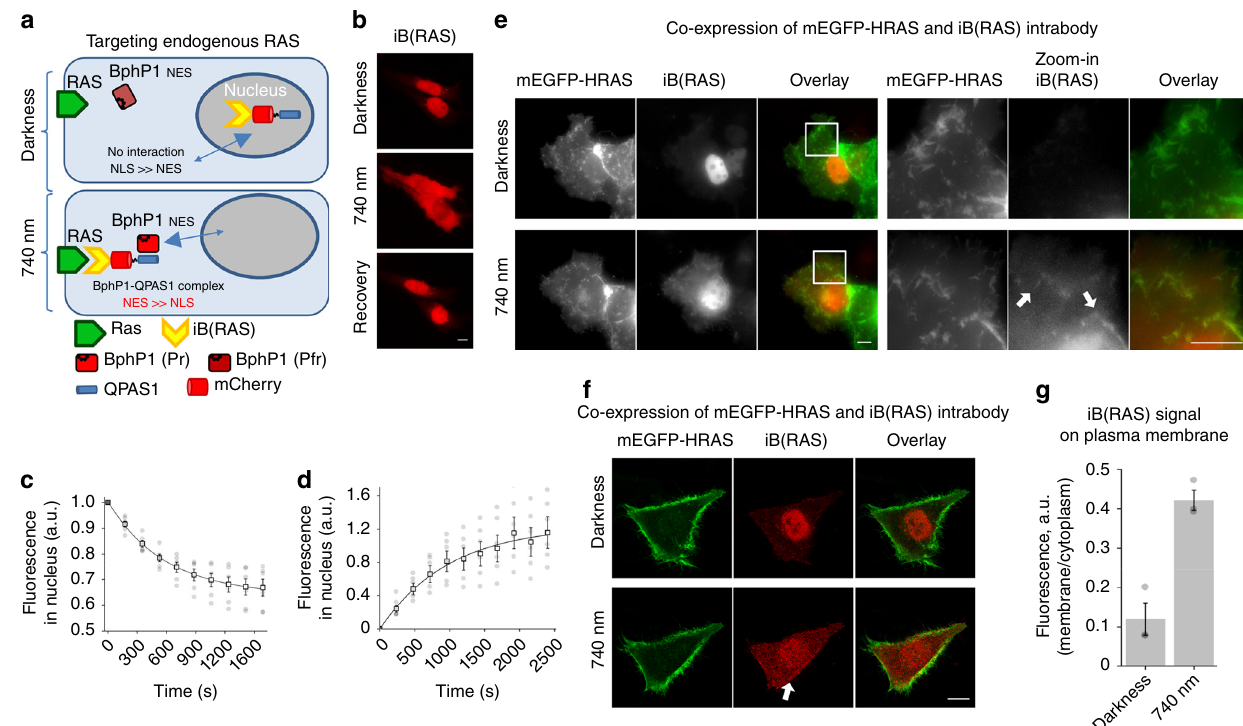
Fig. 6 Engineering of light-controlled intrabody for endogenous RAS. a Schematic representation of a regulation of the intrabody against RAS, designated “ iB(RAS), ” by NIR light. In darkness, the intrabody shuttles between nucleus and cytoplasm, being predominantly in the nucleus. Under 740 nm light, the iB(RAS)-QPAS1 fusion interacts with BphP1-NES and accumulates in the cytoplasm, due to the summation of NES signals from both interacting partners. As a result, the intrabody can reach endogenous RAS on the plasma membrane. b Cells co-expressing BphP1-NES and iB(RAS)-NES-mCherry-QPAS1-NLS. mCherry fl uorescence is observed in the nucleus in darkness and in the cytoplasm under 740 nm light. The process is reversible: in darkness the iB(RAS) moves back to the nucleus. Epi fl uorescence microscopy; scale bars, 10 µ m. c Kinetics of iB(RAS) depletion in the nucleus as detected by mCherry fl uorescence, error bars represent SEM, n = 6 cells. Source data are provided as a Source Data fi le. d Kinetics of the light-driven iB(RAS) accumulation in nucleus (recovery) as a result of BphP1 thermal relaxation, error bars represent SEM, n = 7 cells. Source data are provided as a Source Data fi le. e HeLa cells co-expressing the optically controlled iB(RAS) (red) and mEGFP-HRAS (green). Zoom ins of white frame-marked regions are shown on the right. White arrows show the membrane structures where iB(RAS) and mEGFP-HRAS co-localize. Epi fl uorescence microscopy; maximal projection is shown; scale bar, 10 µ m. f Relocalization from nucleus to cytoplasm of optically controlled iB(RAS) (red) under 740 nm illumination, with subsequent binding of membrane-associated mEGFP-HRAS (green), white arrow. Confocal microscopy; scale bar, 10 µ m. g Mean fl uorescence signal on plasma membrane, shown as membrane-to-cytoplasm ratio, quanti fi ed for three cells similar to shown in f . Error bars represent SEM. The scheme used for the quanti fi cation is presented in Supplementary Fig. 9. Source data are provided as a Source Data fi le.